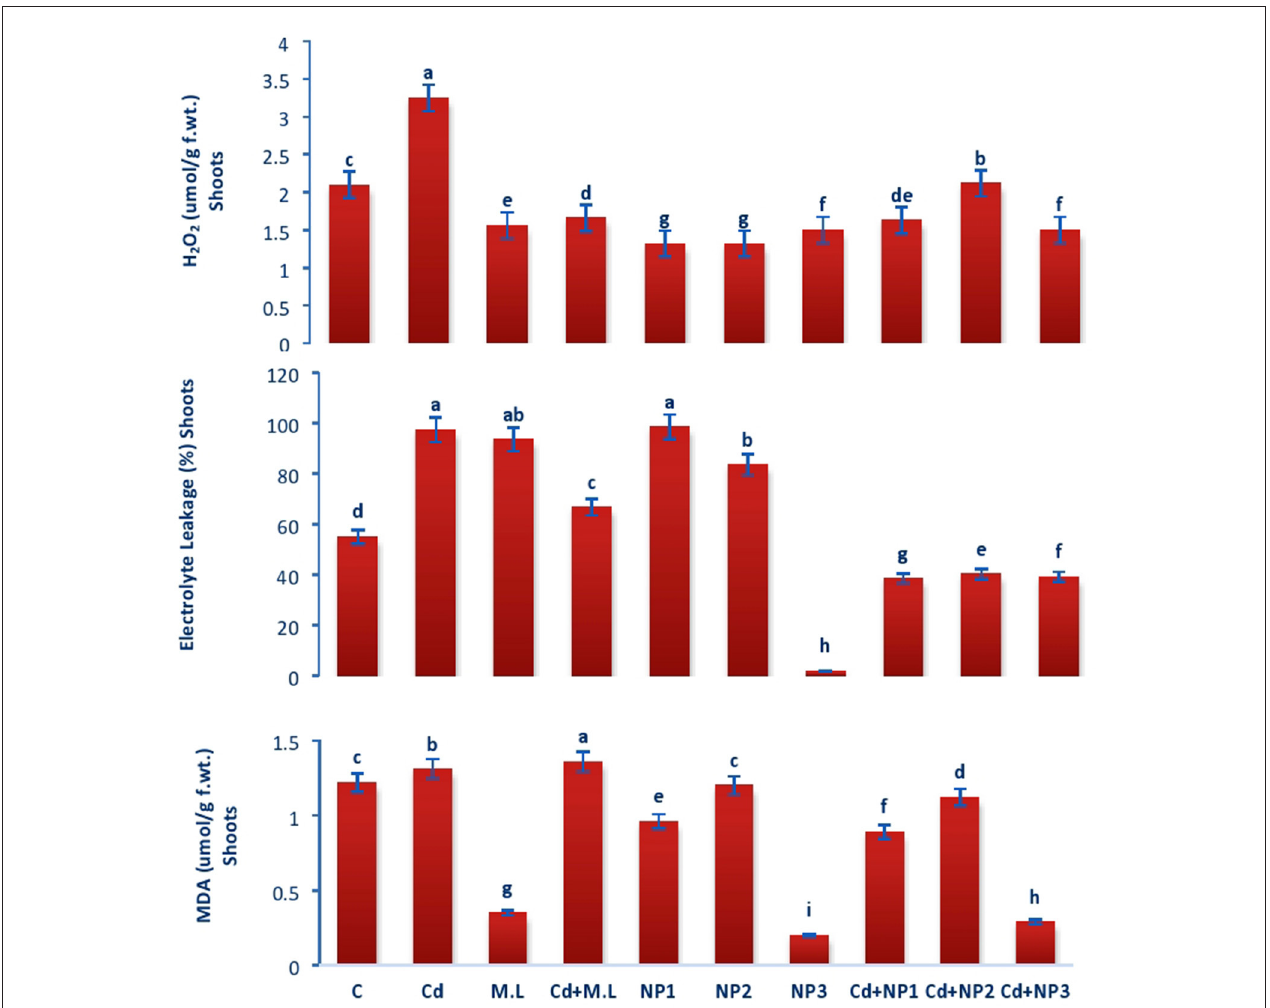
FIGURE 8 | Effects of MZnO–NPs on EL, H 2 O 2 , and MDA under Cd stress in Linseed shoots. Different letters indicate significant difference between the treatments. Data are means ± SE ( n = 5). Non-identical letters specify significant difference at P ≤ 0.05. C, Control; Cd, 100mg kg − 1 Cd; M. L, Moringa oleifera leaves;